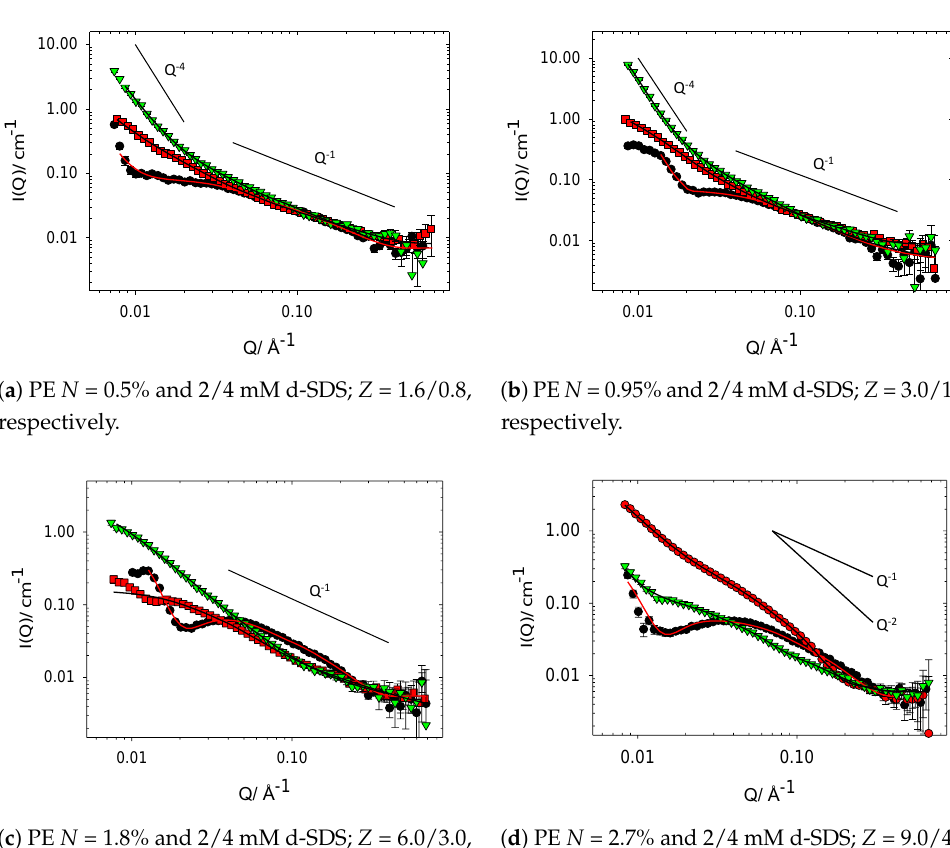
Figure 7. SANS profiles from binary mixtures containing 1 wt% cat-HEC polymers with different degrees of charge modification and d-SDS (PE contrast). Symbols: circles, no SDS; squares, 2 mM SDS; down triangles, 4 mM